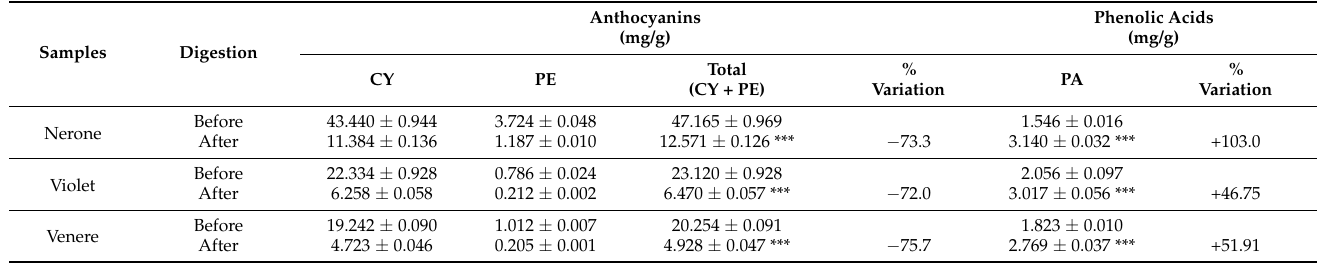
Table 2. Identification and quantification of anthocyanins and protocatechuic acid by the HPLC-DAD technique. Results are expressed as mean ± SD ( n =